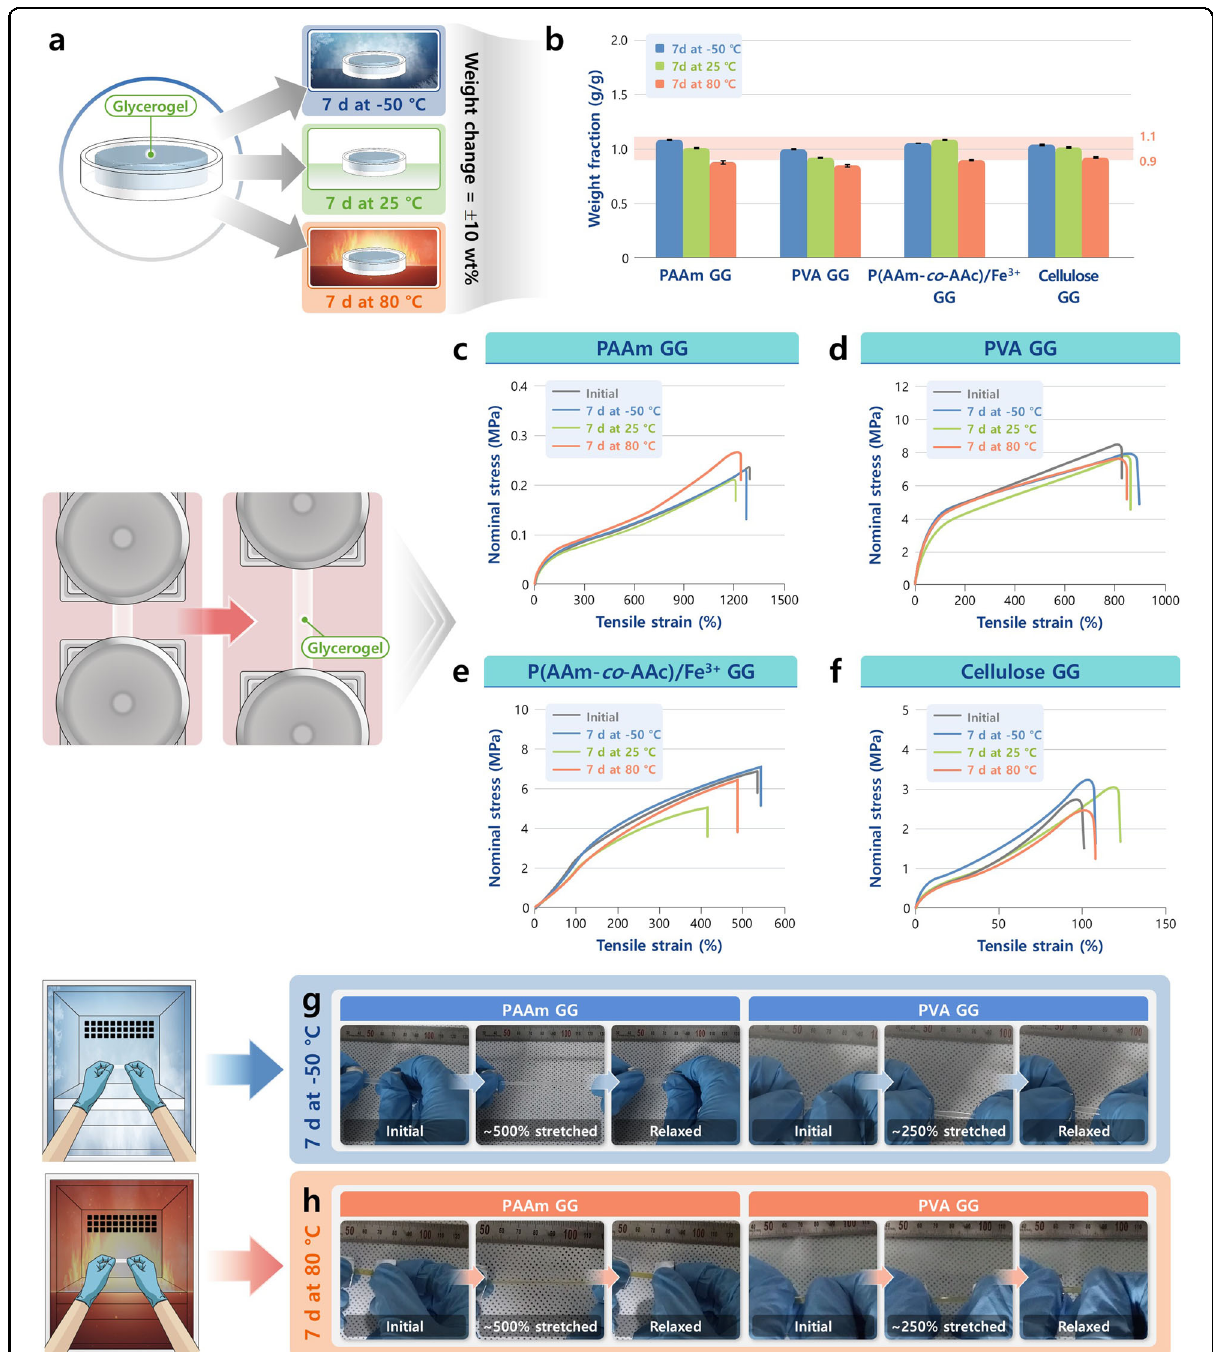
Fig. 3 Characterization of the extremotolerant ability of GGs. a Observation of the effects of low ( − 50 °C), ambient (25 °C), and high (80 °C) temperatures on the fabricated GGs. b Weight fractions of the GGs following incubation for 7 d at − 50, 25, and 80 °C. Representative tensile stress – strain curves of ( c ) PAAm, ( d ) PVA, ( e ) P(AAm- co -AAc)/Fe 3 + , and ( f ) cellulose GGs. Tensile tests are performed on pristine samples, and the results are compared with those of the samples incubated at − 50, 25, and 80 °C for 7 d. Demonstration of the stretchability of PAAm and PVA GGs following incubation for 7 d at ( g ) − 50 °C and ( h ) 80